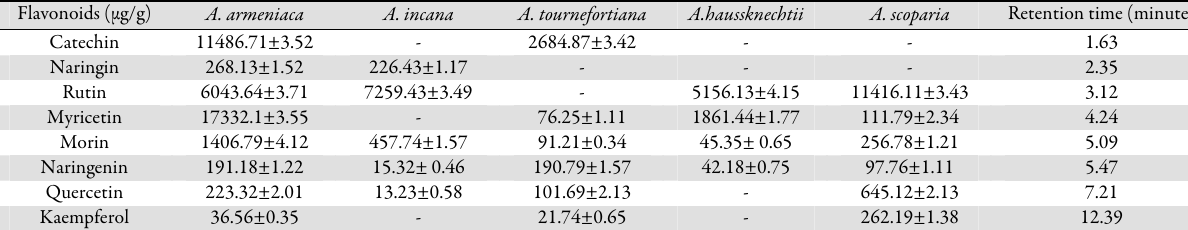
Table 4. Flavonoid contents of studied Artemisia species Flavonoids